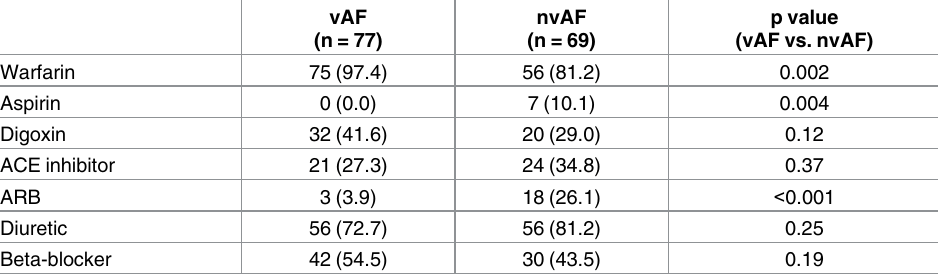
Table 2. Medication use before study entry for atrial fibrillation